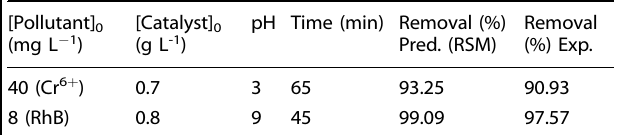
Table 1. RSM-based optimal conditions for photocatalytic Cr 6 + reduction and RhB